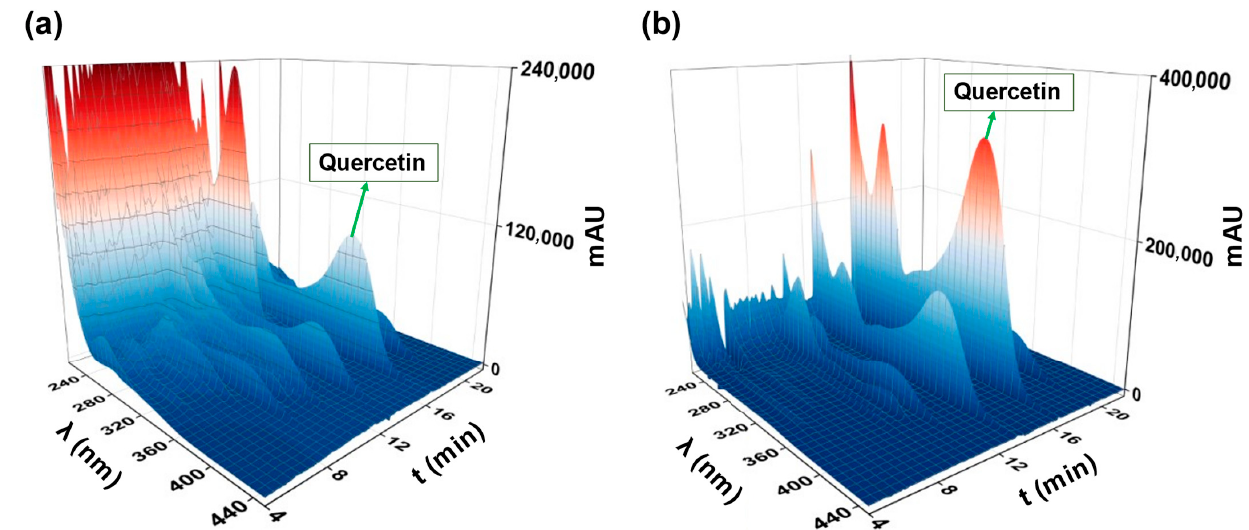
Figure 9. Three-dimensional chromatograms: ( a ) RDE extract; ( b ) fraction 7.